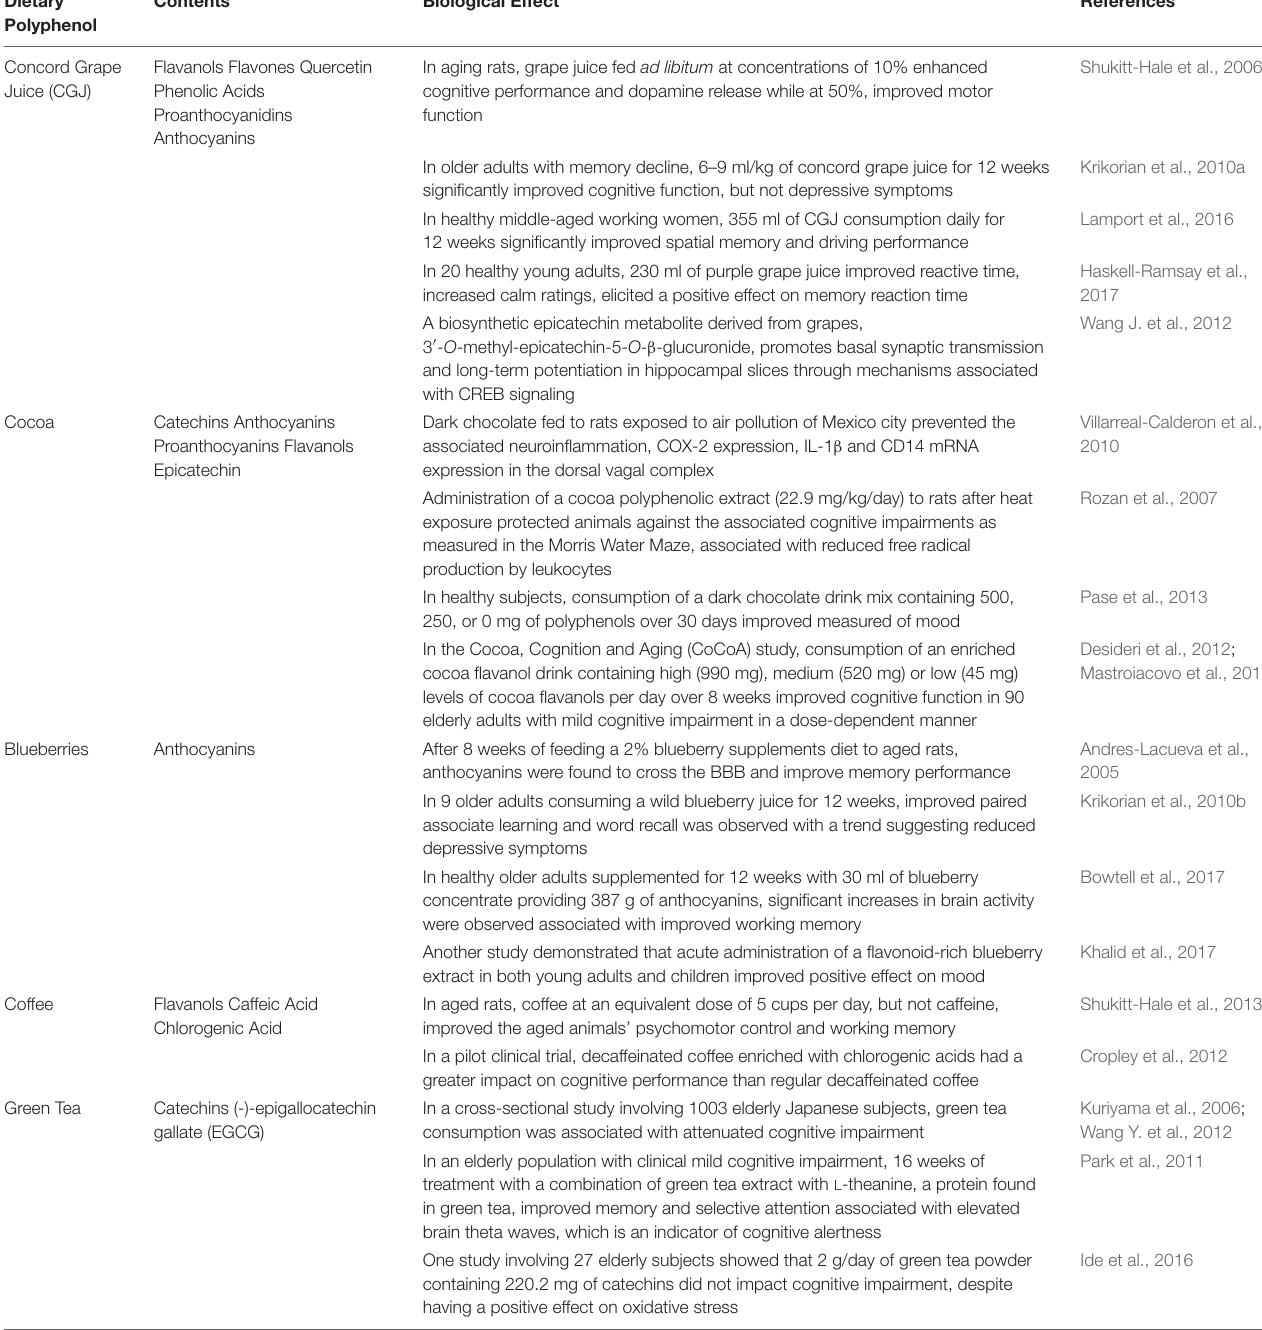
TABLE 1 | Effect of complex polyphenolic substances on markers of